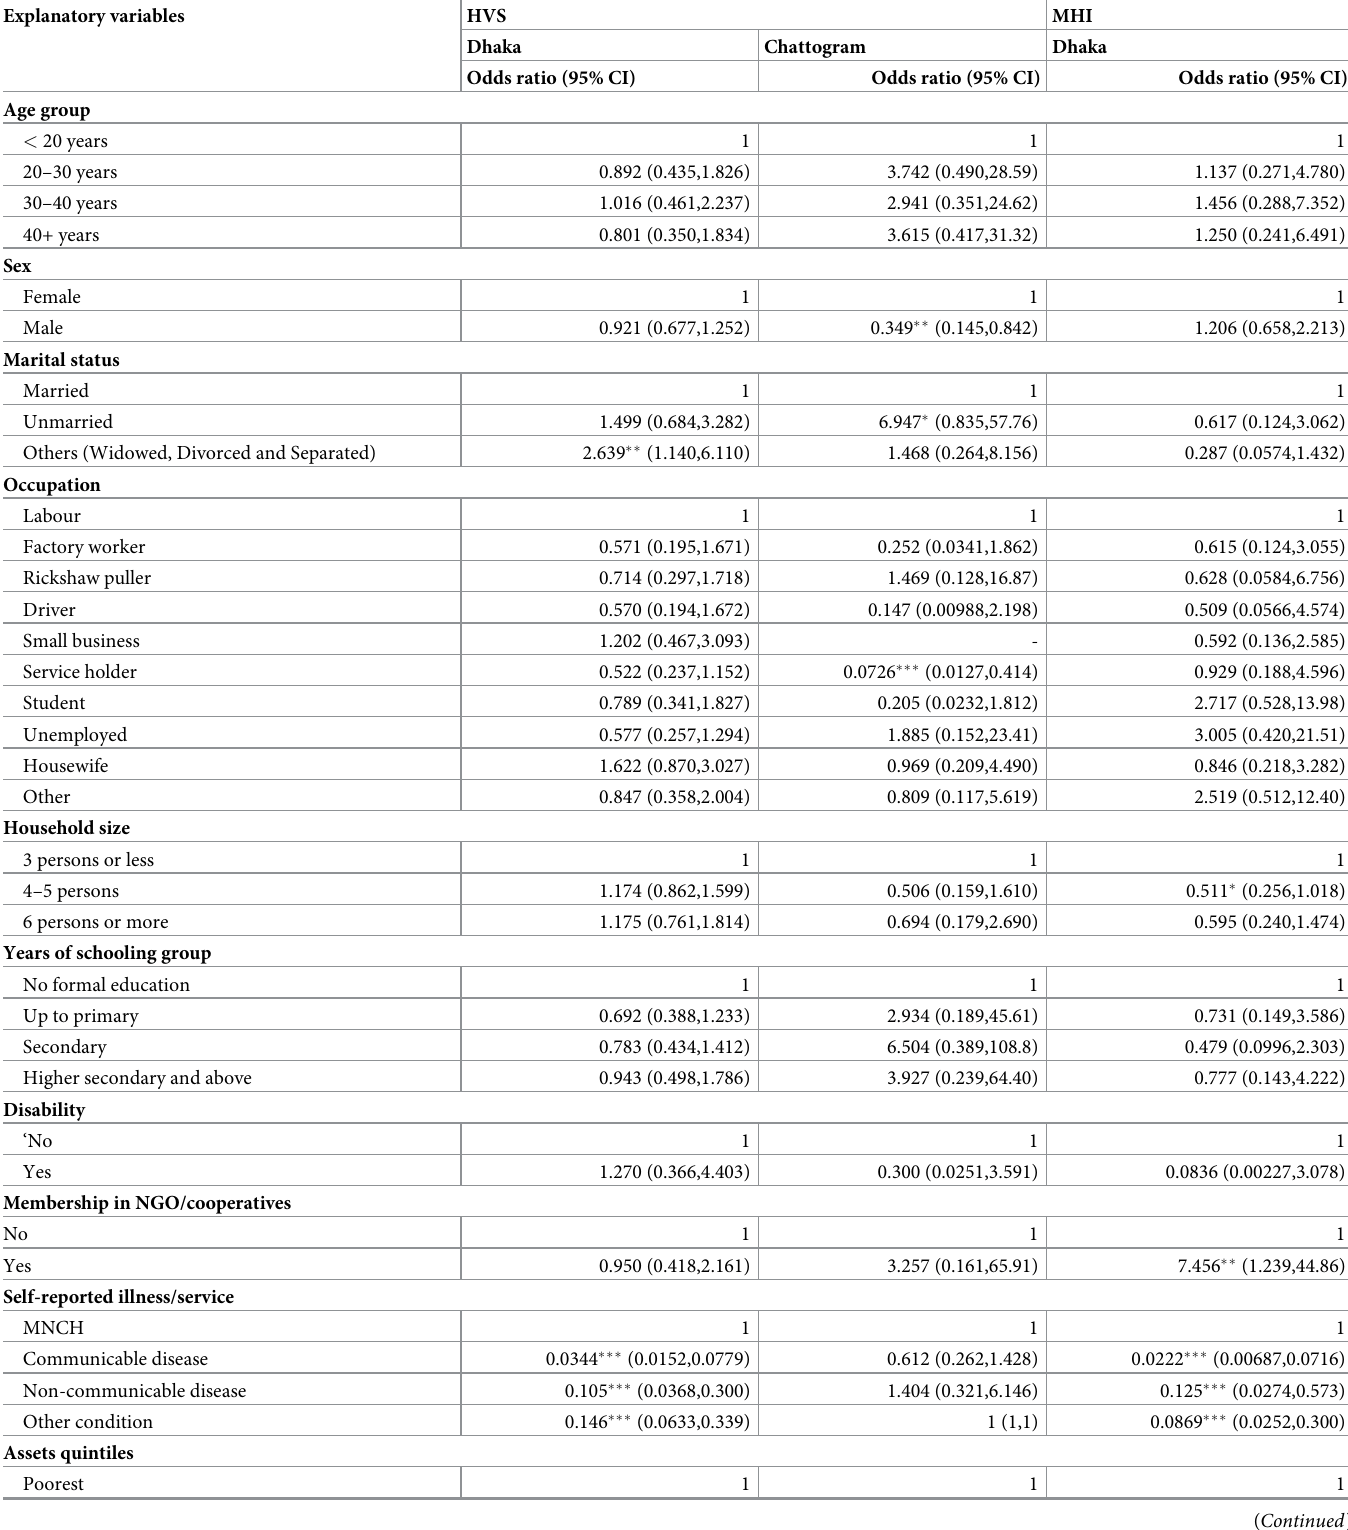
Table 6. Factors of MTP provider utilization by health